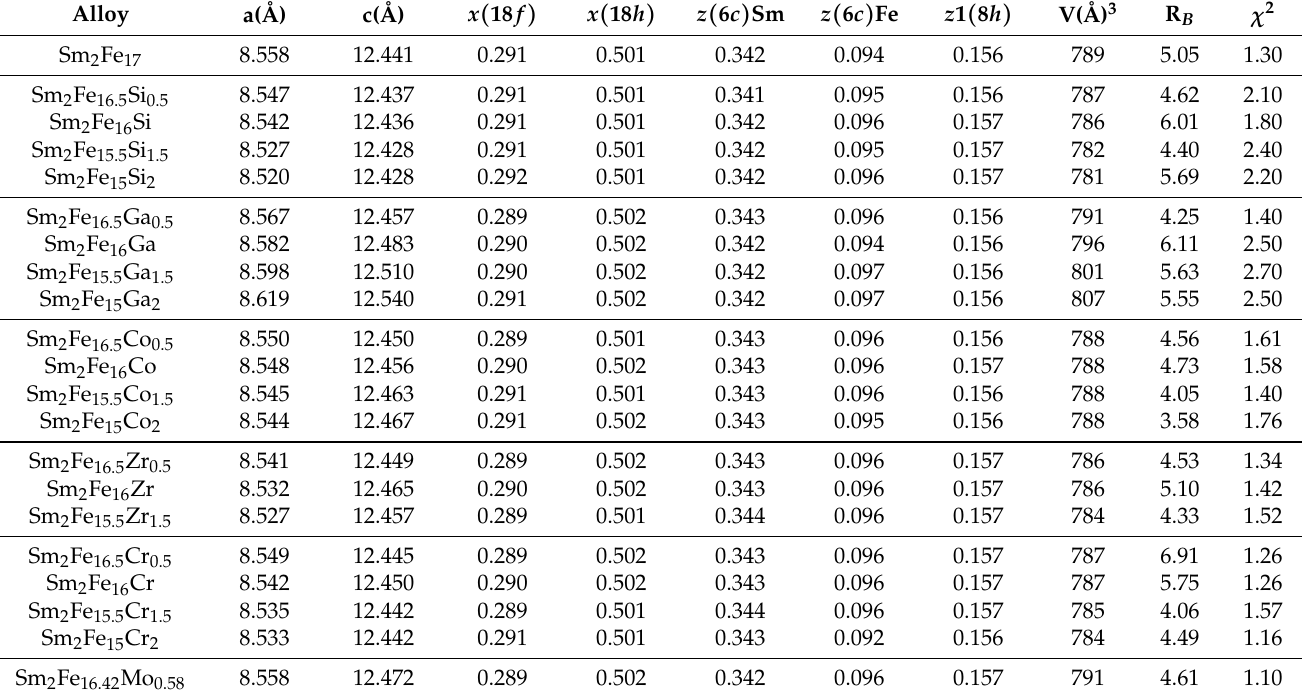
Table 3. XRD analysis results obtained by Rietveld method on the Sm 2 Fe 17 − x M x ( M = Si, Ga, Co, Zr, Cr, Mo) and ( x = 0, 0.5, 1, 1.5, 2) alloys